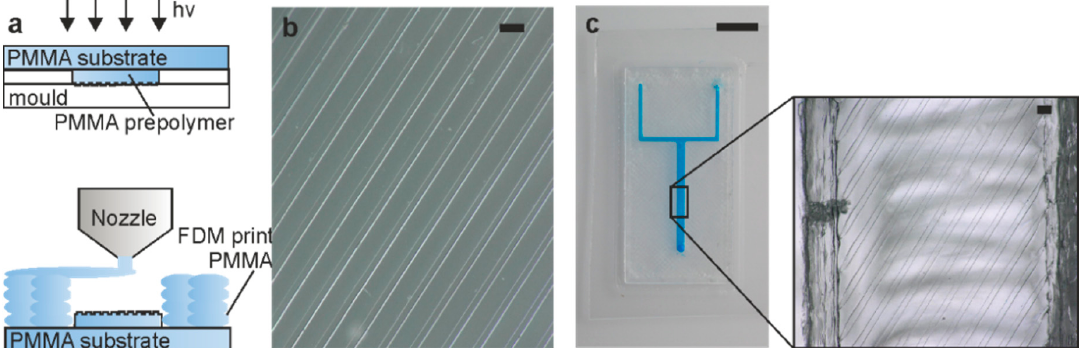
Figure 4. Integration of high-resolution PMMA structures inside a FDM-printed channel structure. ( a ) Principle of integration of high-resolution microstructures inside the FDM printed channel. The microstructure is fabricated by polymerizing a PMMA prepolymer directly on a commercial PMMA substrate using a lines-and-space structure. The PMMA substrate is then aligned and fixed within the FDM printer and the microfluidic channel is printed around the microstructure. ( b ) Polymerized PMMA microstructure fabricated using photocurable PMMA prepolymers (scale bar: 100 µm). ( c ) FDM printed PMMA chip including the microstructure from ( b ) (scale bar: 10 mm). The inset shows the integrated microstructure (scale bar: 100 µm).